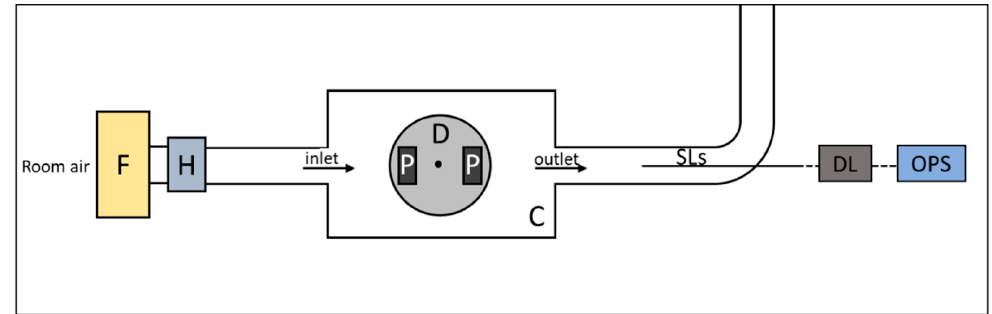
Figure 2. Scheme of the experimental setup. F: fan; H: HEPA filter; C: Chamber; D: disc; P: pad; DL: diluter, SLs: sampling lines; OPS: TSI ® OPS. DL: diluter, SLs: sampling lines; OPS: TSI ®